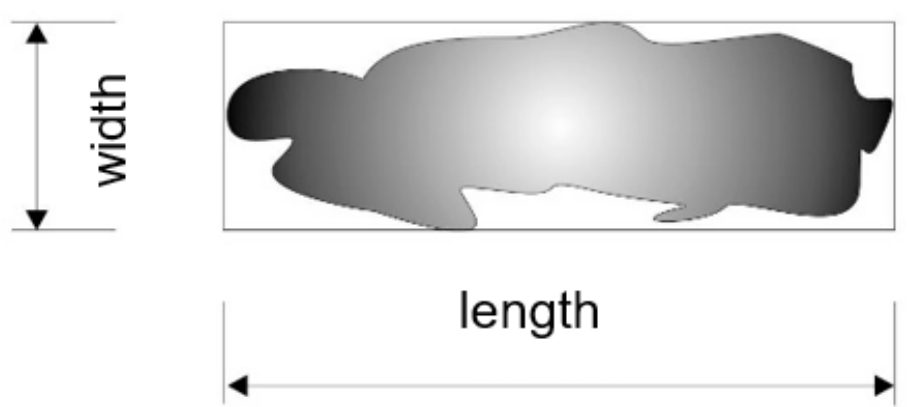
Figure 3. Basic dimensions of disintegrated wood mass particles